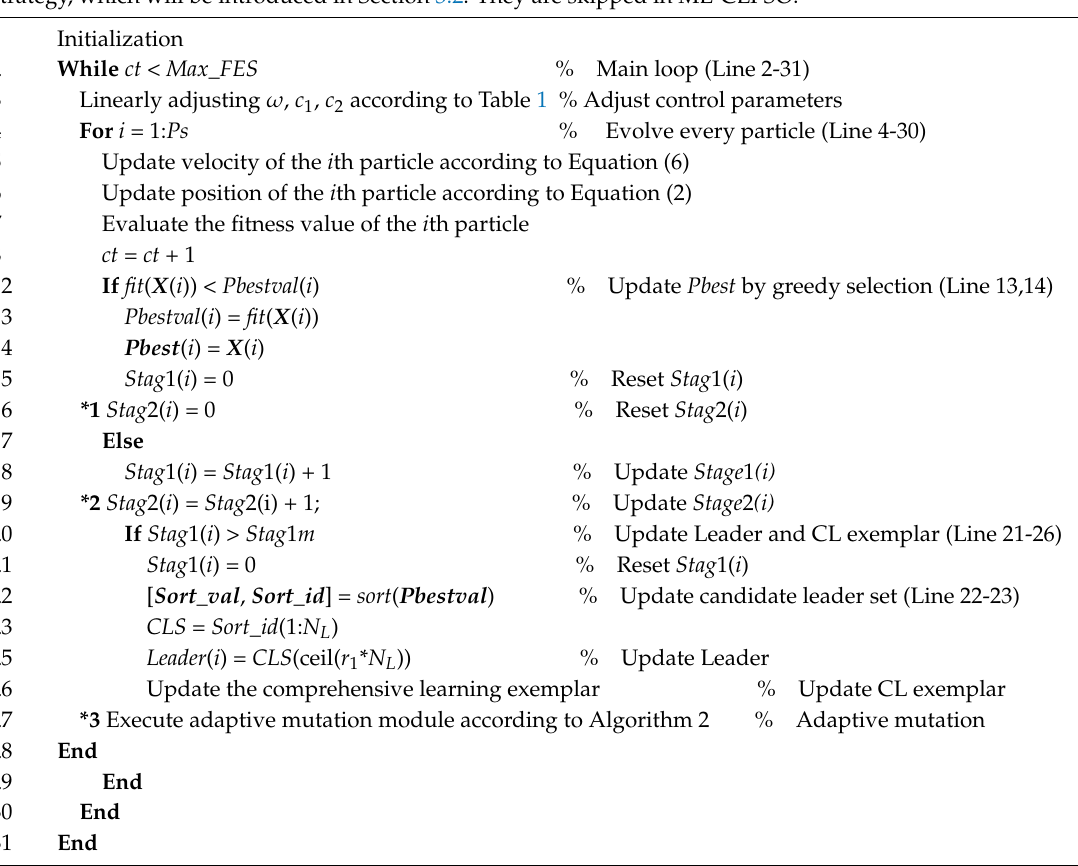
Algorithm 1. The pseudo code of ML-CLPSO. * Note: the line with *1 , *2 , *3 are alternative steps for the AM strategy, which will be introduced in Section 3.2. They are skipped in